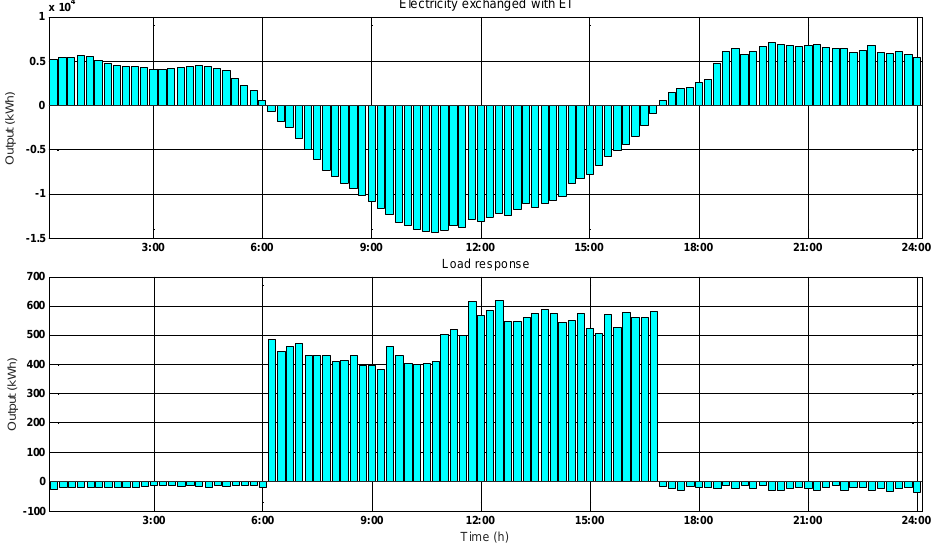
Figure 10. The output power of the electricity exchanged with EI and LR system in Scenario Three.